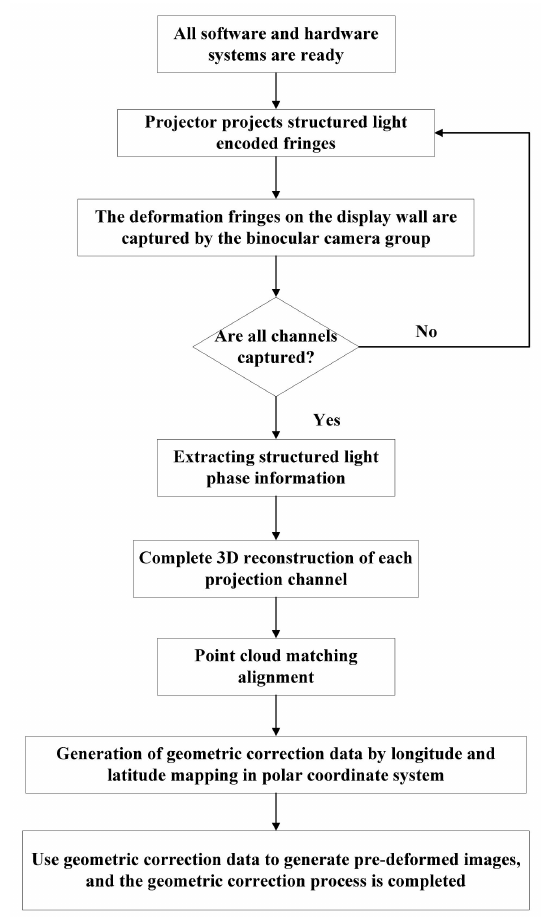
Figure 8. Procedure of geometric correction based on binocular